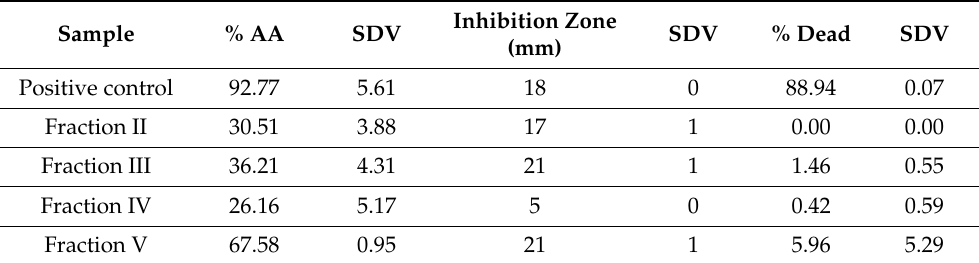
Table 3. Antioxidant activity, antimicrobial activity against Gram-positive S. aureus, and toxicity towards Artemia salina .